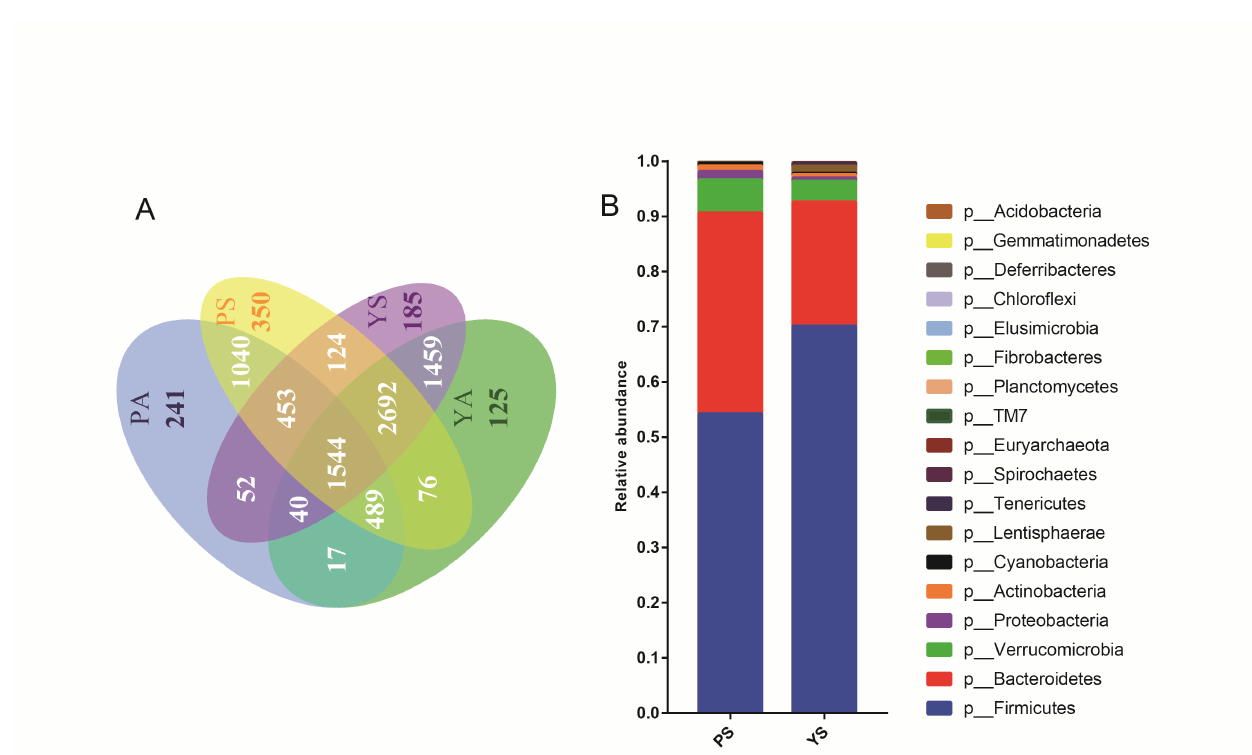
Figure 5. The horizontal transmitted OTU cluster number between the sympatric pikas and yaks. The “PA”: the pikas in the allopatric enclosure, “PS”: sympatric pikas with yaks, “YS”: sympatric yaks with pikas, and “YA”: yaks in allopatric farms. ( A ) The section labeled 2692 denotes those OTU clusters which plateau pika acquired from sympatric yak; the section labeled 453 denotes those OTU clusters which yak acquired from the sympatric plateau pika. ( B ) Relative abundance of horizontal transmitted bacteria at phylum level in sympatric pikas and